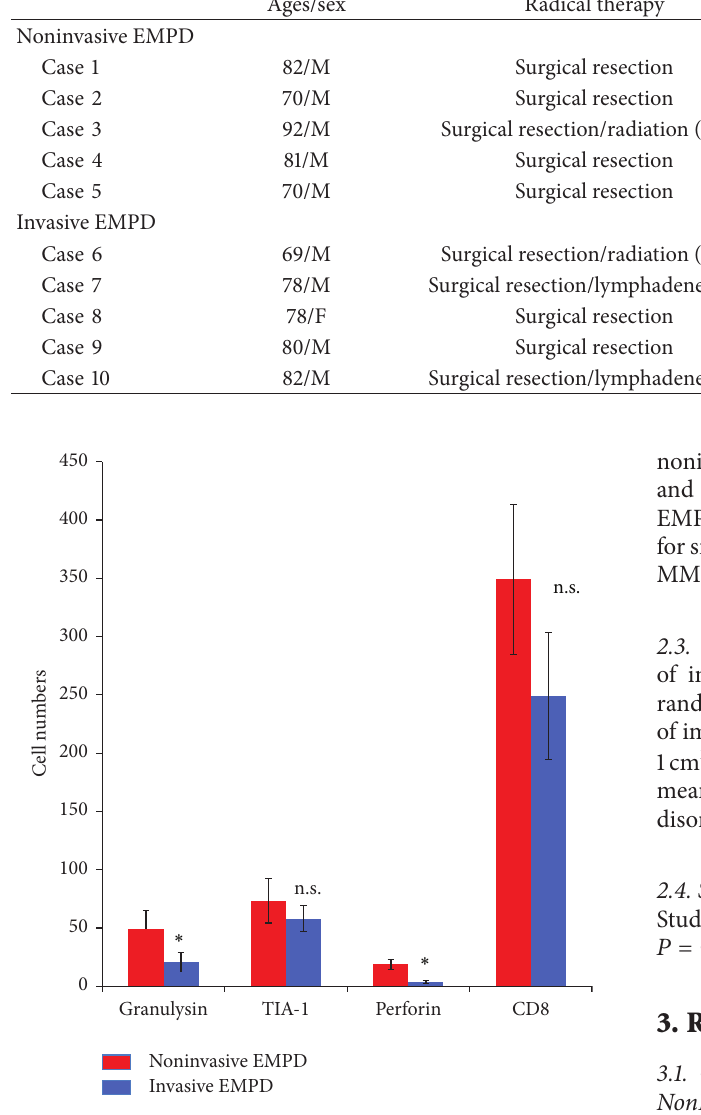
Figure 2: Summary of the numbers of CD8+ cells, granulysin bearing cells, TIA-1+ cells, and perforin+ cells in noninvasive and invasive EMPD. Five representative fields of each section were selected from each group of EMPD. The number of immunoreactive cells was counted using an ocular grid of 1cm 2 at a magnification of 400x. The data are expressed as the means SD of the numbers in each area. Stars: 𝑃 < 0.05